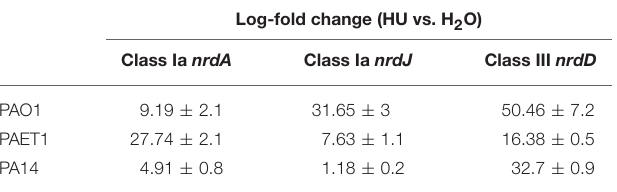
TABLE 4 | Expression of nrdA, nrdJ, and nrdD genes of P. aeruginosa PAO1 and clinical isolates (PAET1 and PA14) strains with HU. Log-fold change (HU vs. H 2 O)